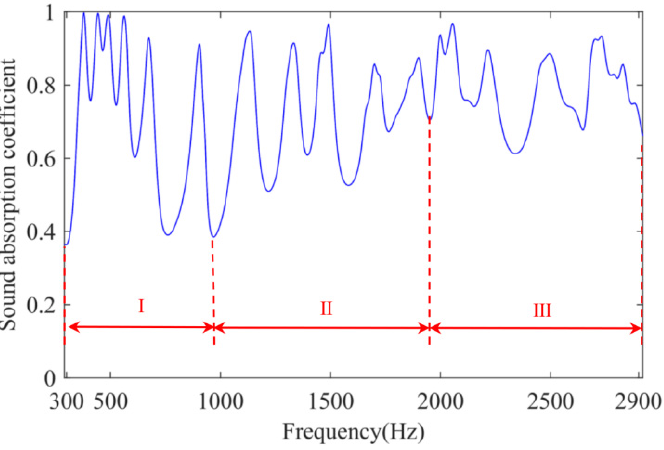
Figure 4. Distribution of the sound absorption coefficients in the MSC-AM in simulation.